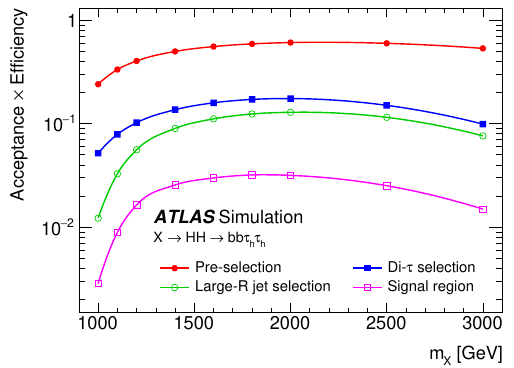
Figure 10. Signal acceptance times selection efficiency as a function of the resonance mass, at various stages of the event selection. From top to bottom: an event preselection (red solid-circle: trigger, object definitions and E miss